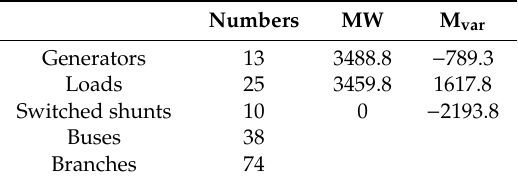
Figure 5. One-line diagram of the reduced 38-bus Korean power system.